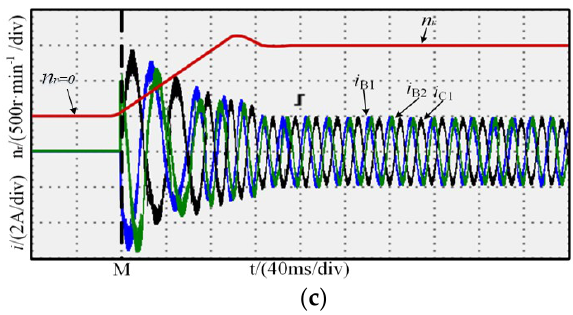
Figure 9. Start-up process experiment: ( a ) normal; ( b ) MCC; ( c ) MTO.